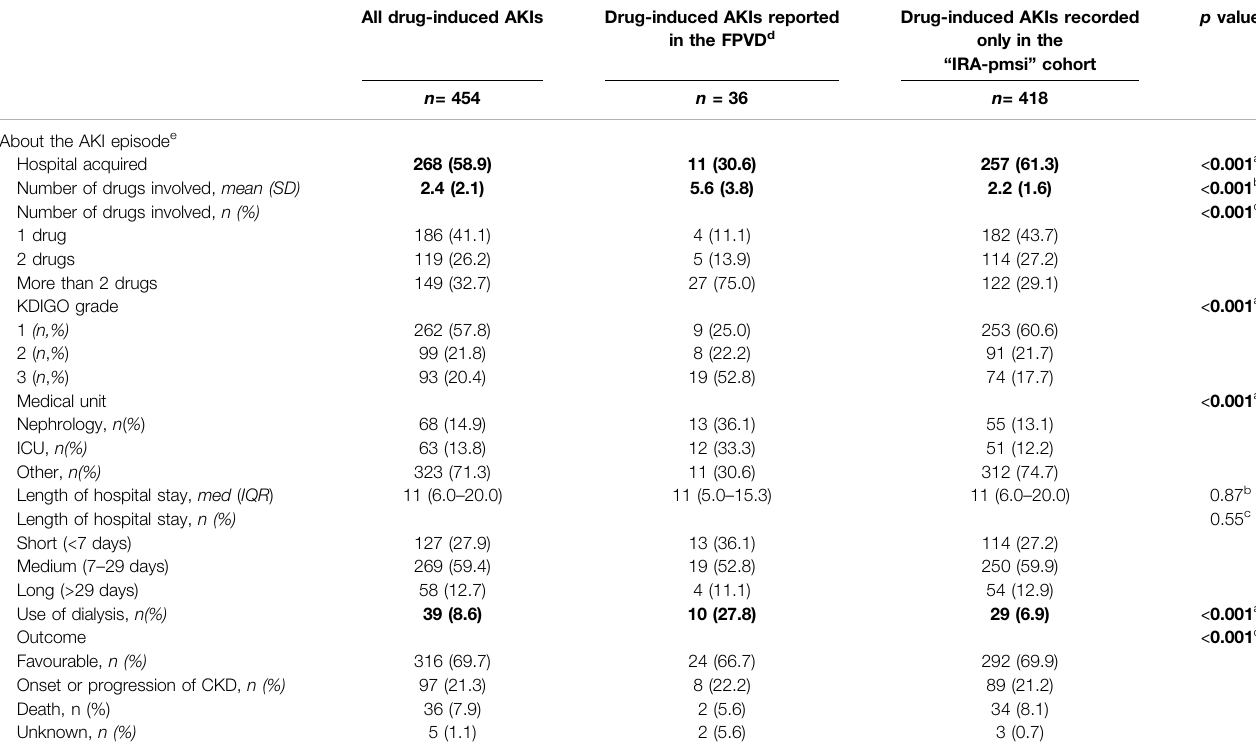
TABLE 2 | Characteristics of the episodes of drug-induced AKI, by data source. All drug-induced AKIs Drug-induced AKIs reported in the FPVD